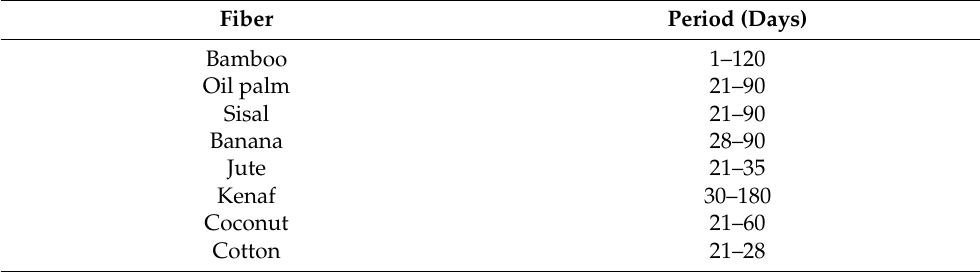
Table 2. Degradation periods of natural fibers